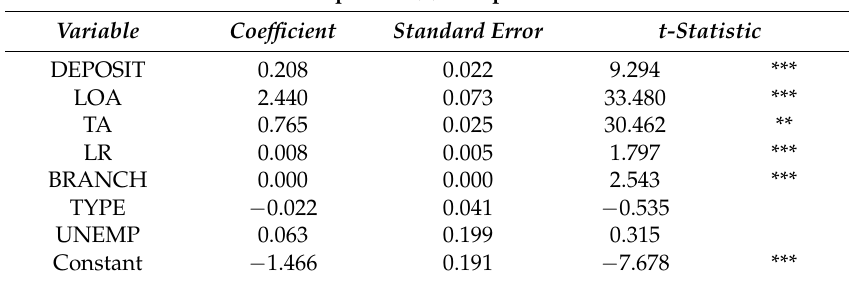
Table 3. Results of SEM analysis. Panel A. Results of Equation (9)—Dependent Variable: